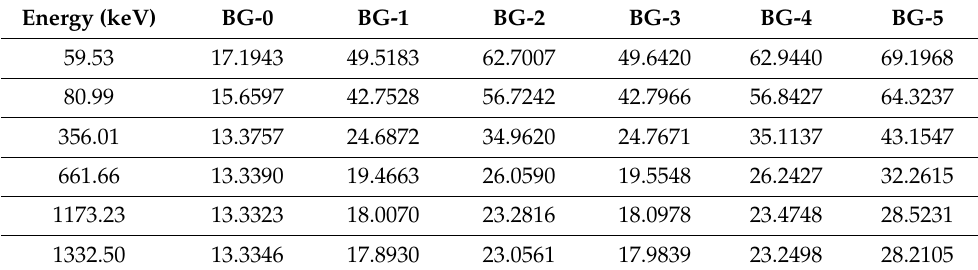
Table 4. The effective atomic number (Z eff ) of all tested specimens.